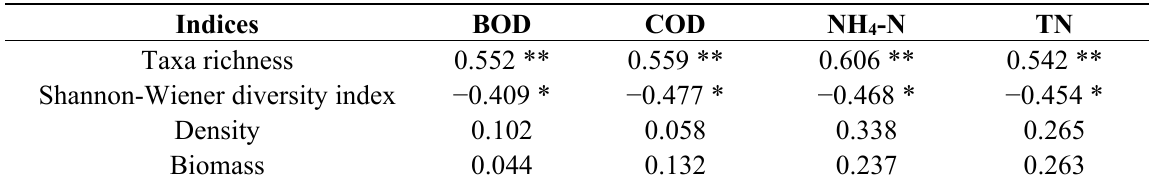
Figure 5. Relative changes in the macroinvertebrate diversity index and water quality indices. Table 4. Correlations between macroinvertebrates indices of and water quality indices. The data are from February and September